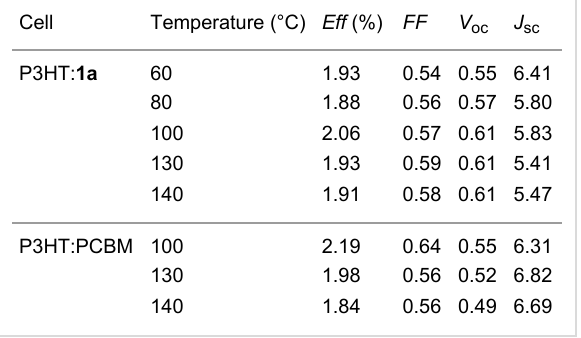
Table 3: J – V characteristic parameters of P3HT: 1a - and P3HT:PCBM- blended solar cells at different annealing temperatures